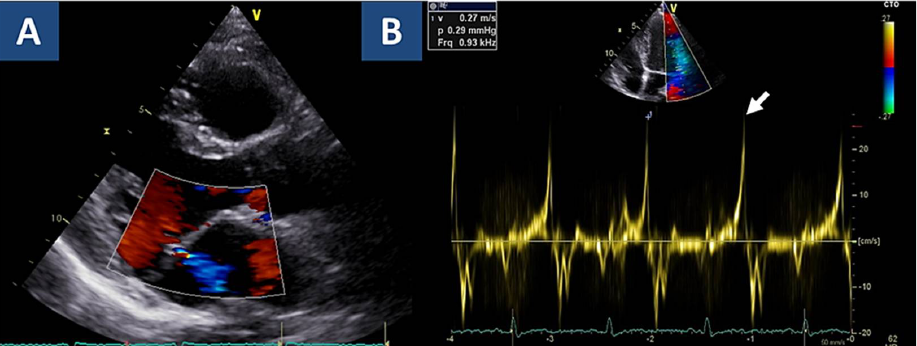
Figure 4. Echocardiographic findings. Legend. A —Parasternal long axis view shows mild mitral valve regurgitation. Associated curling of the basal inferolateral wall is shown as Supplementary Video. B —As a hallmark of increased arrhythmic risk, Pickelhaube sign (spiked systolic lateral mitral annular velocity >16 cm/s) is shown (arrow).